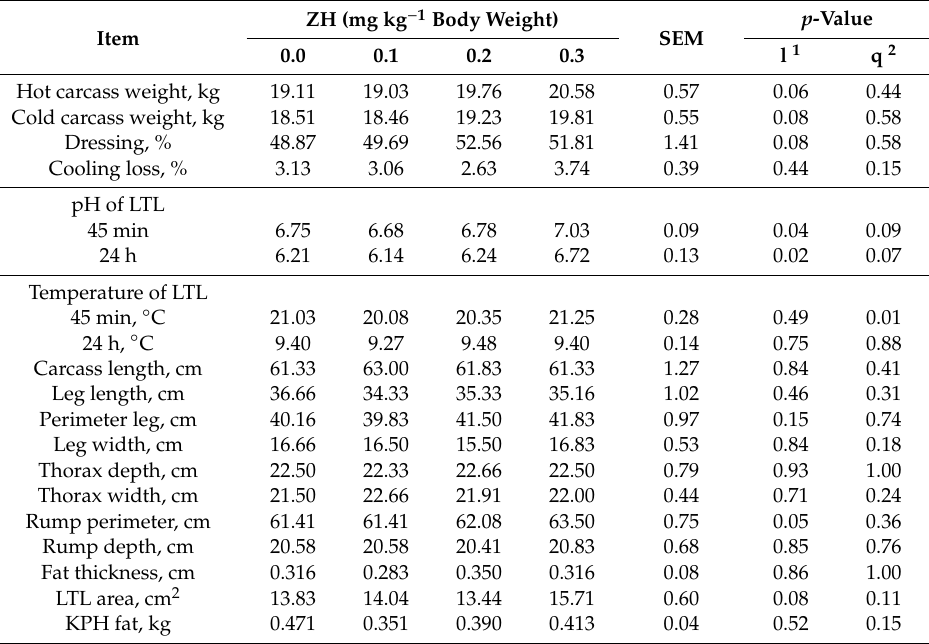
Table 3. Carcass characteristics of hair-breed lambs supplemented with di ff erent levels of ZH for 29